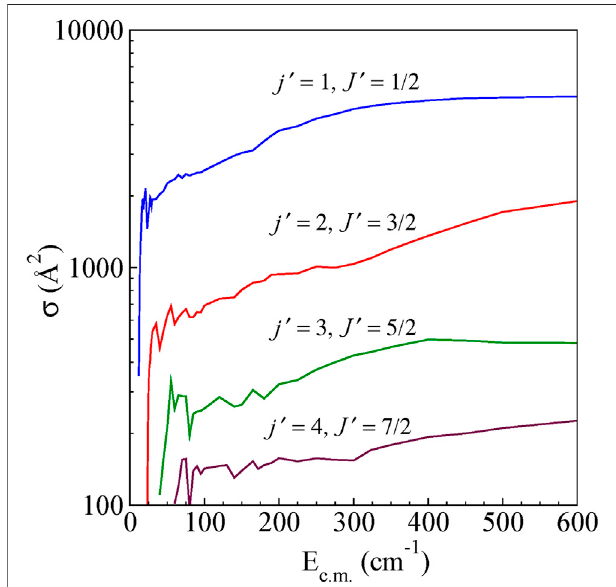
FIGURE 4 | State-to-state integral cross sections for rotational excitationsfor Δ J (cid:1) Δ j transitionsfromtheinitiallevel j (cid:1) 0and J (cid:1) ½forH + + CN ( j (cid:1) 0 , J (cid:1) ½) → H + + CN ( j ′ , J ′ ) .